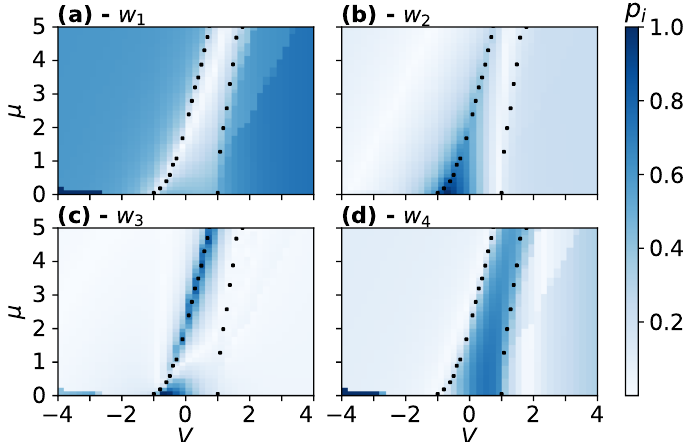
Figure 3: PCA of the interacting Hamiltonian Projection of the interacting corre- lation functions along the principal components obtained applying PCA to the non interacting dataset. Darker colors correspond to areas of the phase diagram which are more similar to the principal component w ( i = 1,2,3,4) used for the projection. i QLCs drawn in (a) and (d) highlight the trivial (superconduting and charge density wave) and topological phases respectively. In both cases, the CAT phase is highlighted by higher values of p compared to the other phases. Component (c) pins down a i phase transition line whereas component (b) does not seem to be informative on the interacting dataset. The projections of all four plots are rescaled independently. The dots are the same as panel (c) of Fig. 1, added to help recognize the phase transition